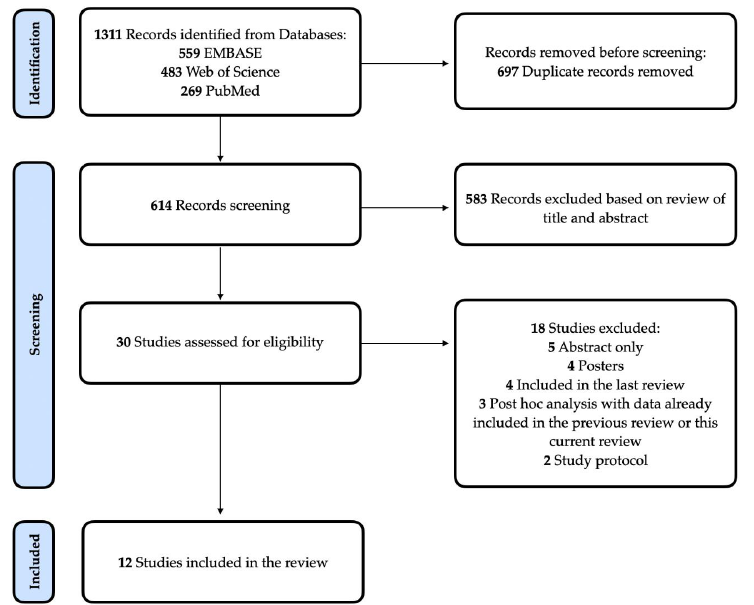
Figure 1. PRISMA Flow Diagram . Flowchart describing the systematic search strategy, including the identification, screening, and inclusion of relevant studies. identification, screening, and inclusion of relevant